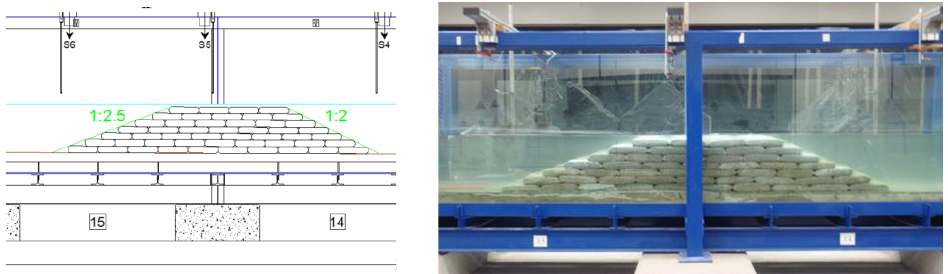
Figure 7. Sketch and physical model of the submerged barrier with 7 layers of GSCs and a submergence R c = − 0.032 m.